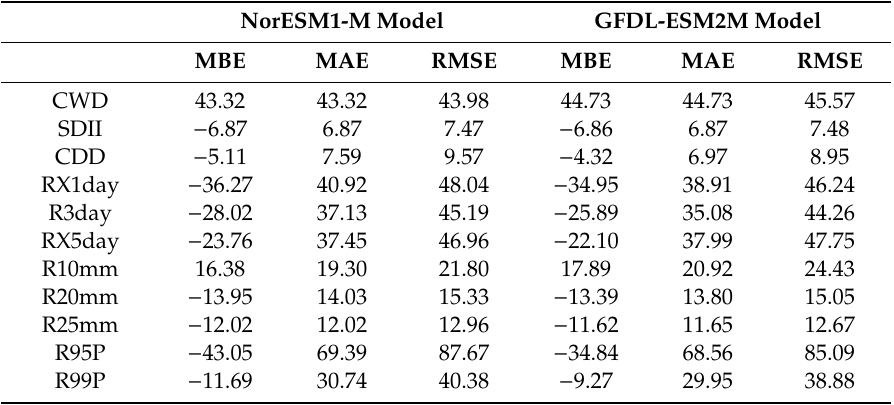
Table 14. Average of the statistical criteria of the indices for all the stations studied